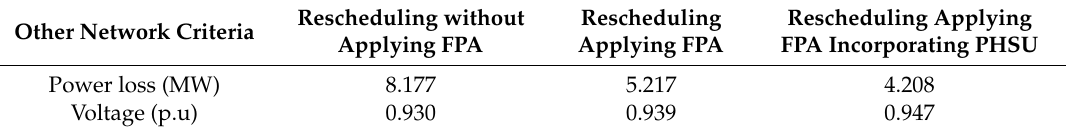
Table 10. Influence of FPA on other network criterion in the test case.